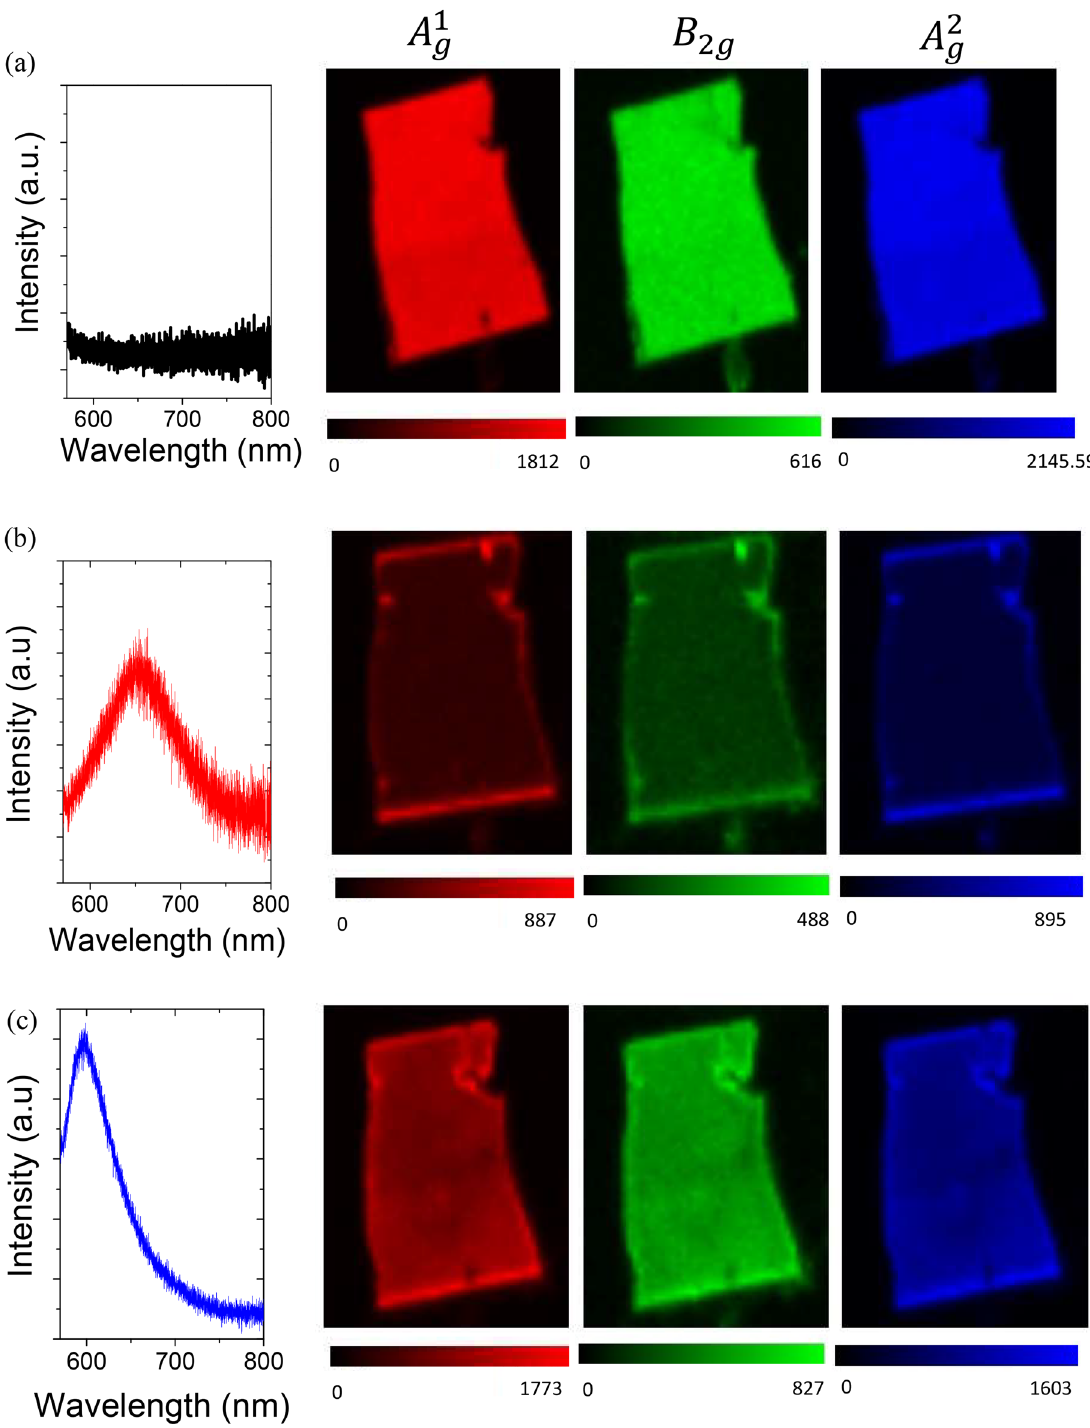
, B 2 g , and A 2 modes for a pulsed thermally annealed black phosphorus g g